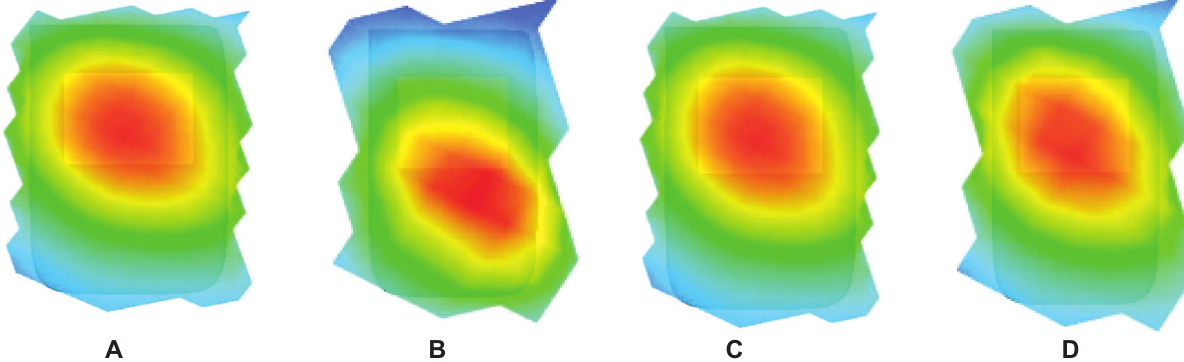
Figure 6 Comparison of SAR values between different positions without SSRRs and with SSRRs